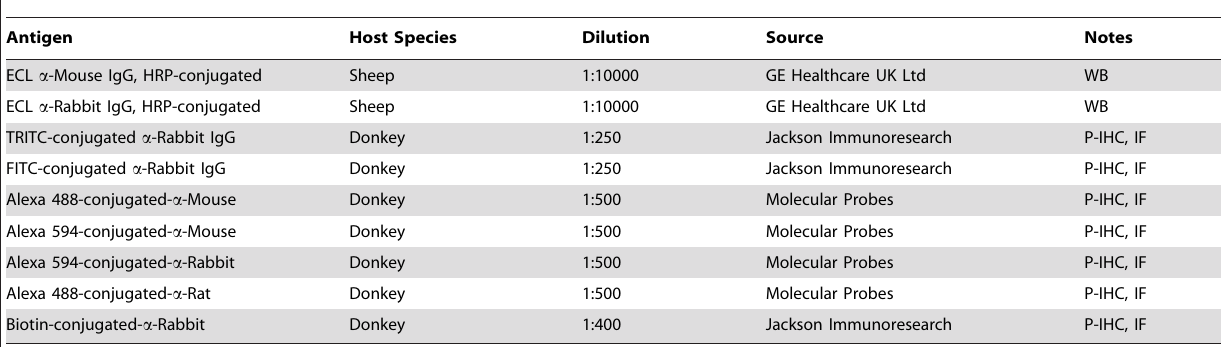
Table 2. Details of secondary antibodies used in this study.